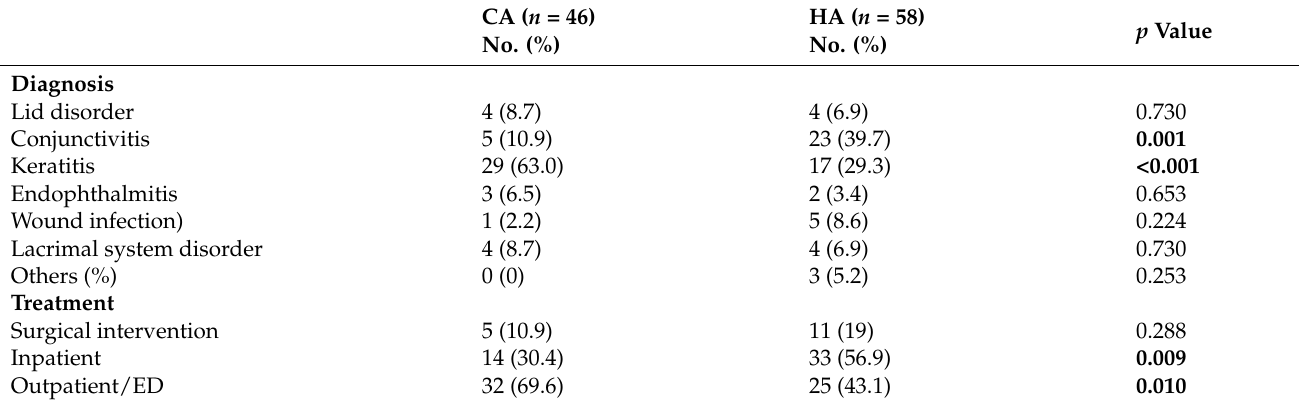
Table 2. Comparison of diagnoses and treatments between community-associated and health-care-associated methicillin- susceptible Staphylococcus aureus ocular isolates.